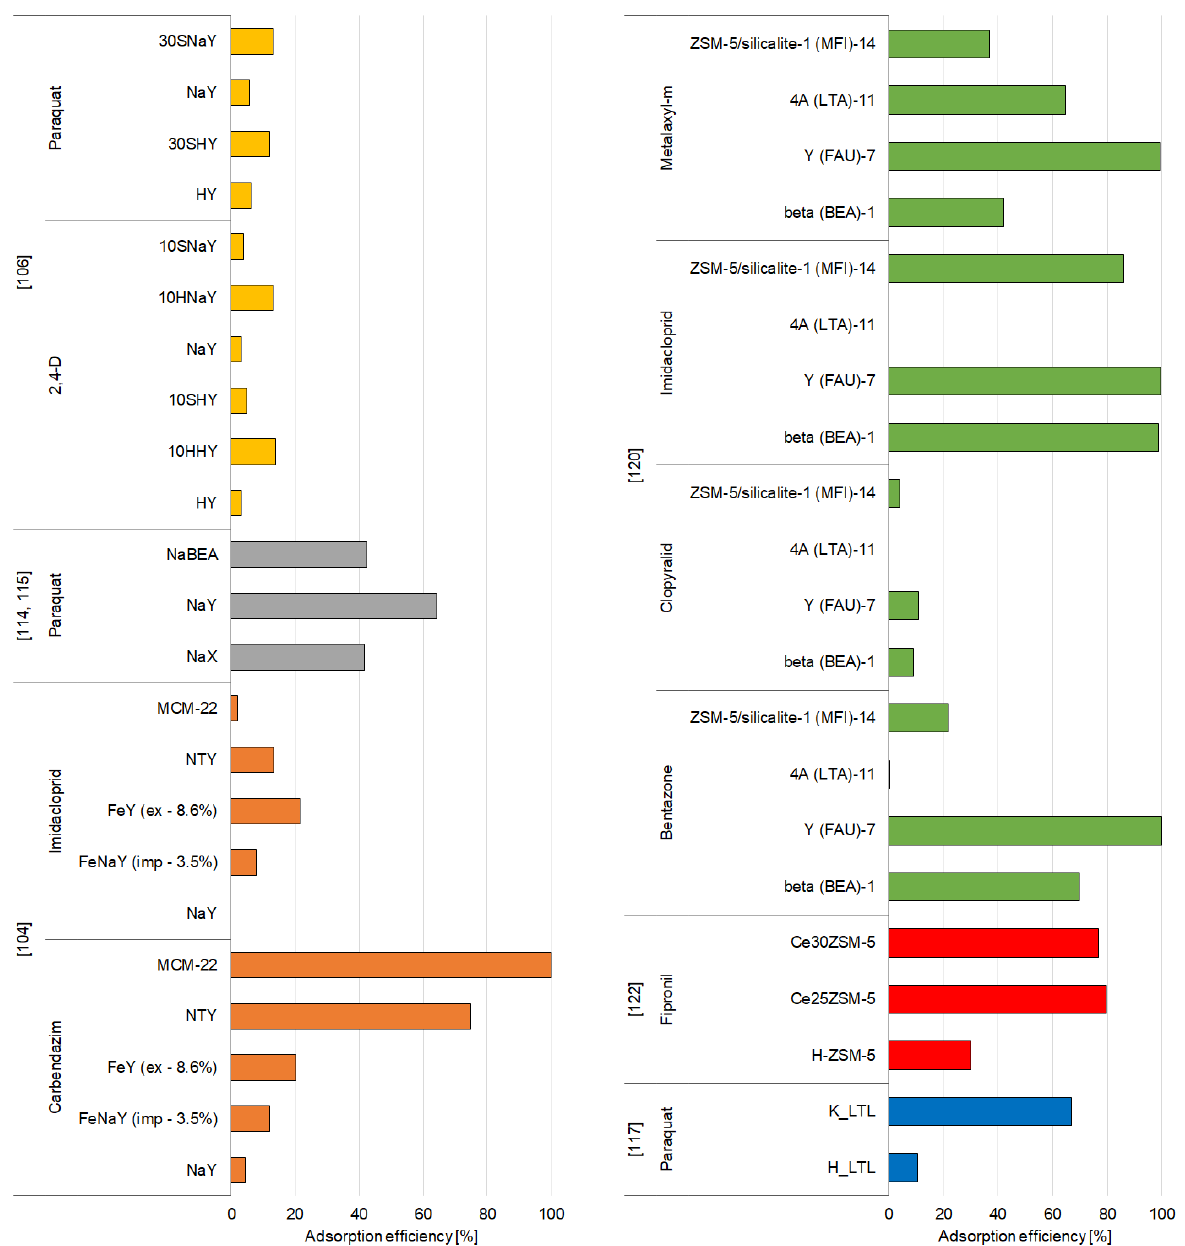
Figure 6. Effectiveness of removal of different groups of pesticides by synthetic zeolites. Triazine and Urea